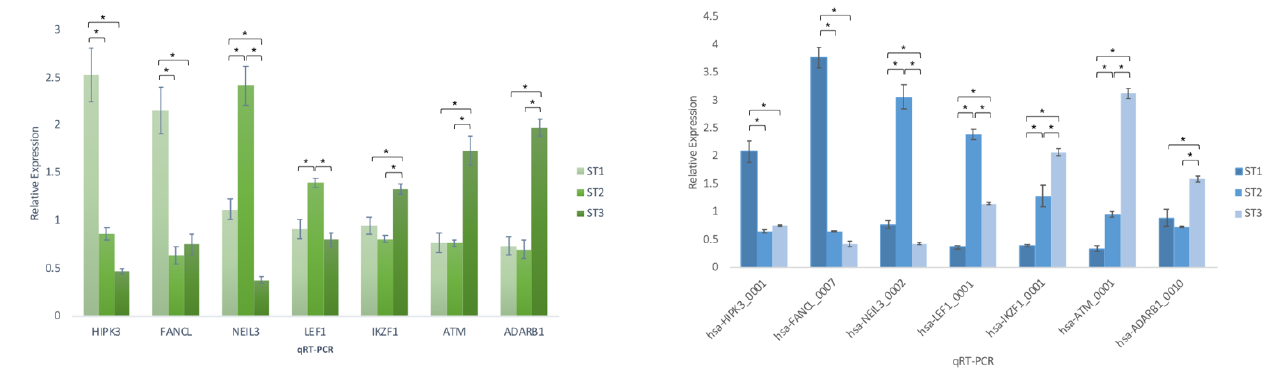
Figure 4. qPCR validation of linears (mRNAs) and their counterparts circRNAs. Quantitative data are presented as the mean ± standard deviation (SD). One-way ANOVA analysis and paired Student’s t -test were used to assess significance among groups. Following one-way ANOVA, Tukey’s post hoc test was performed. SPSS software (v27; SPSS, Inc., Chicago, IL, USA) was used to process all statistical analyses. All tests were performed in triplicate ( n = 3). A p -value < 0.05 was considered to indicate a statistically significant difference. * Denotes a statistical significance.